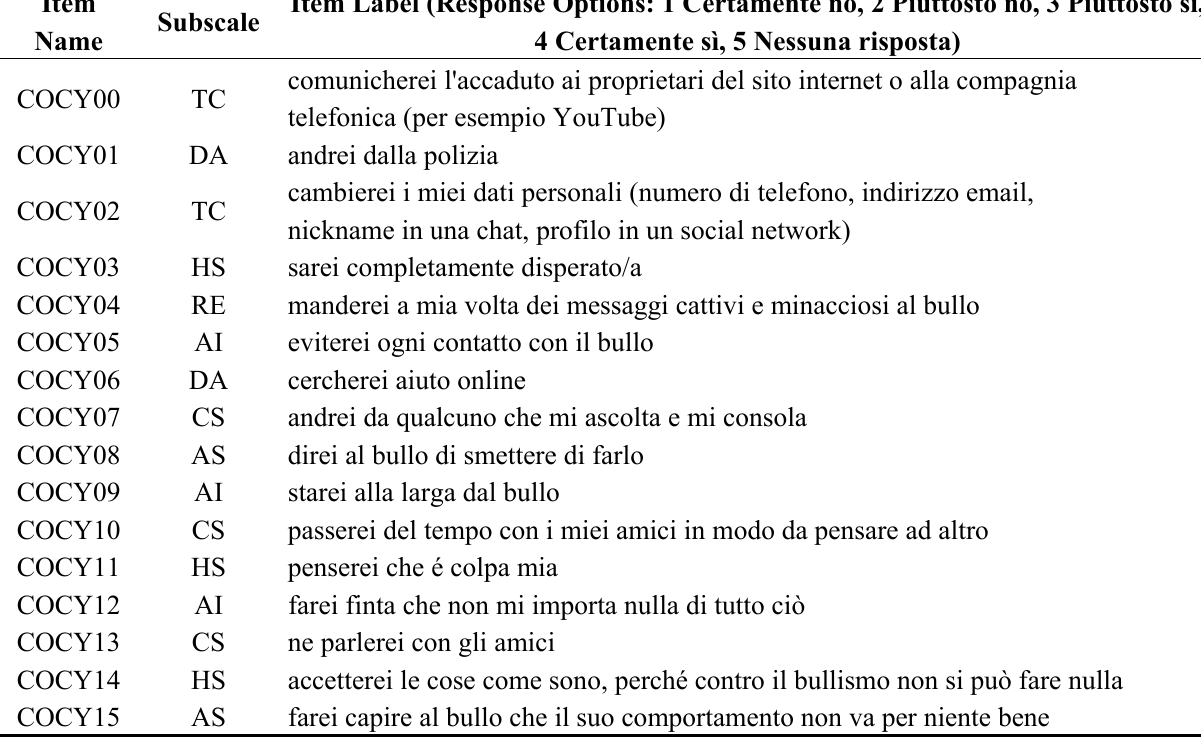
Table A3. Current Italian version of the Coping with Cyberbullying Questionnaire